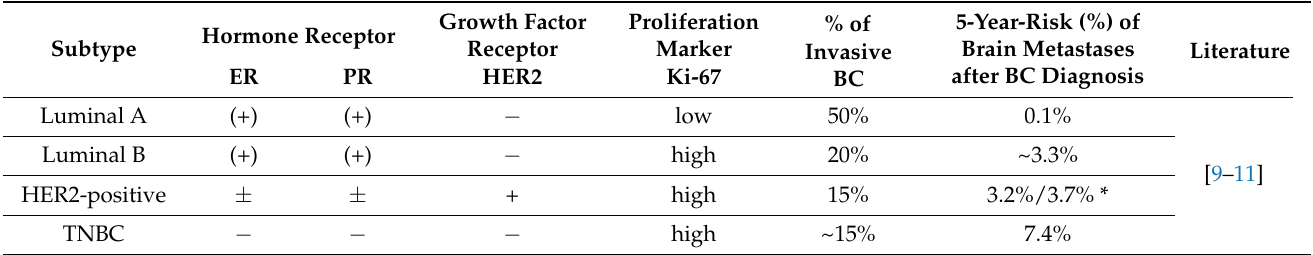
Table 1. Overview of the four clinically relevant molecular subtypes of BC, based on the expression of hormone and growth factor receptors and the proliferation marker Ki-67, and their association with brain metastasis